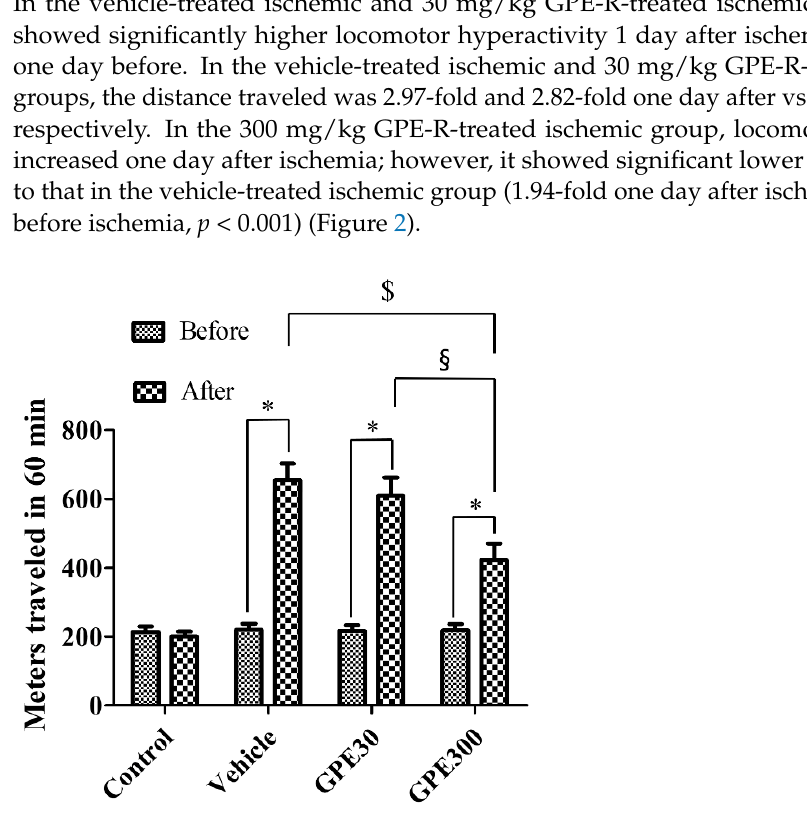
Figure 2. Locomotor activity in the control, vehicle-treated ischemic (Vehicle), 30 mg/kg GPE-R- treated ischemic (GPE30), and 300 mg/kg GPE-R-treated ischemic (GPE300) groups. The total distance (meters) traveled in 60 min was observed 1 day before and after ischemia/reperfusion ( n = 7 per group, * p < 0.05 vs. the control group; $ p < 0.05 vs. the vehicle group; § p < 0.05 vs. the GPE30 group). Error bars represent standard errors of the means.